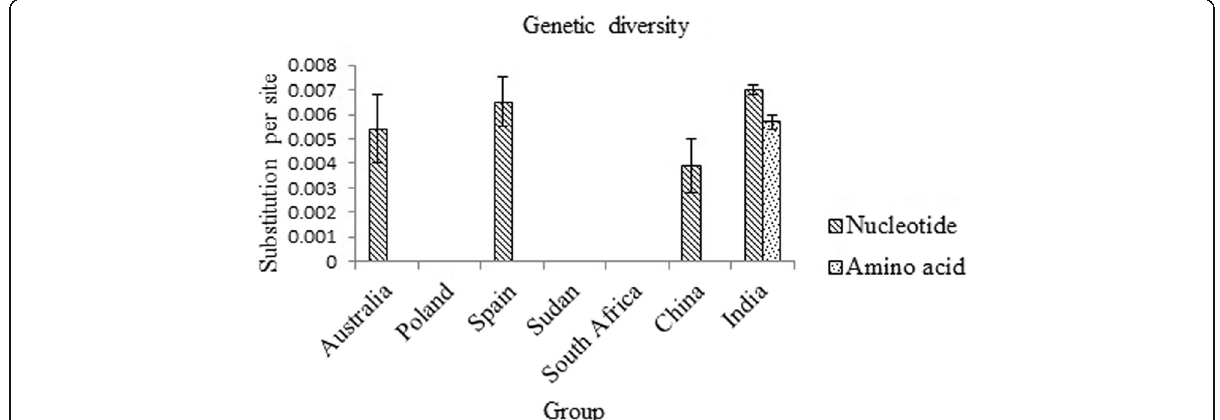
Fig. 3 Pairwise genetic diversity of Hear NPV isolates from different geographical regions